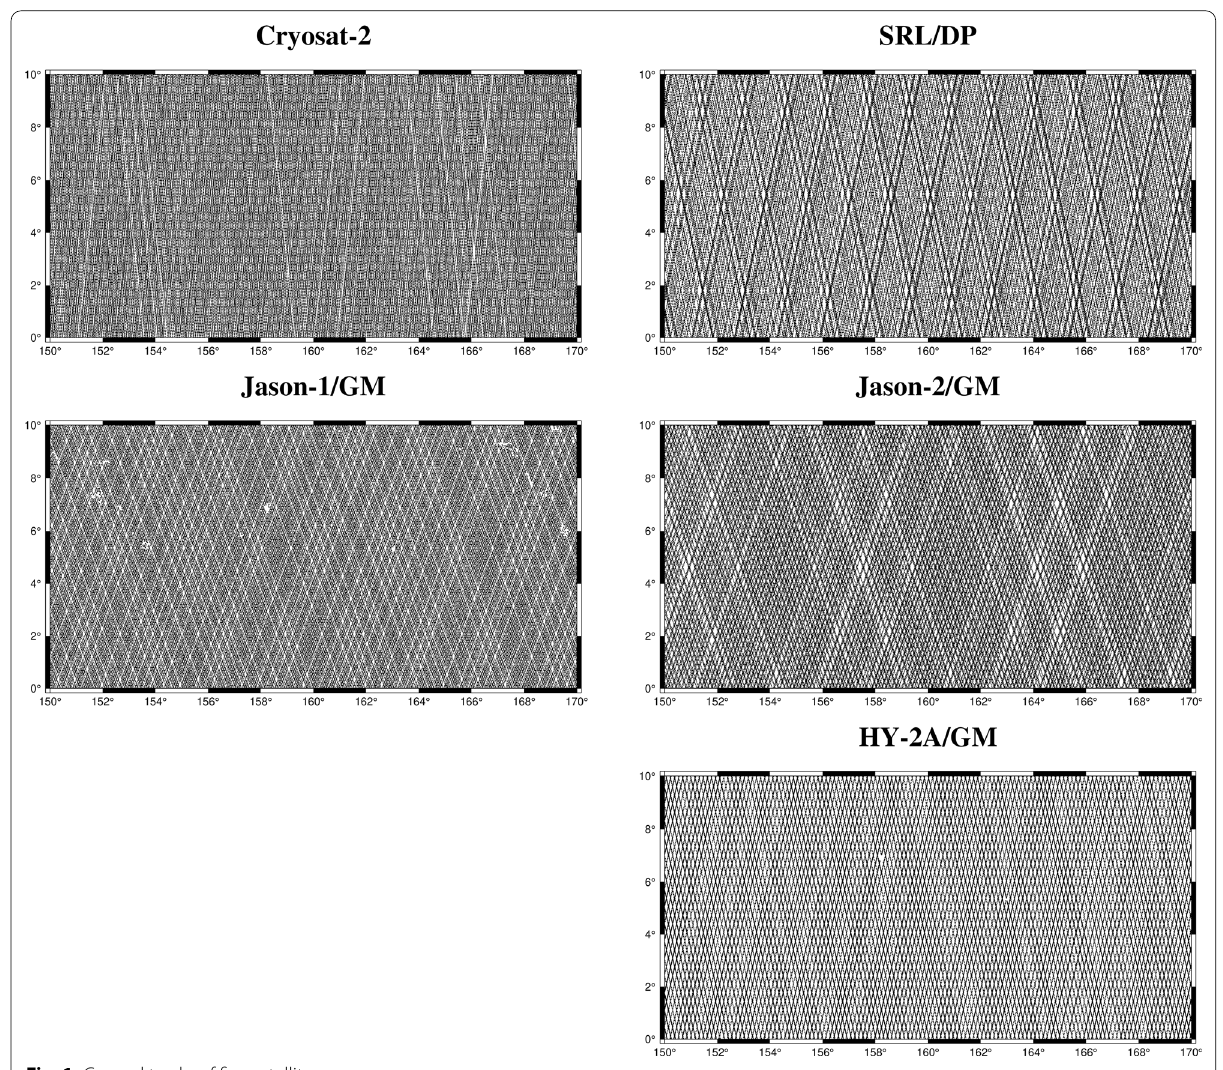
Fig. 1 Ground tracks of five